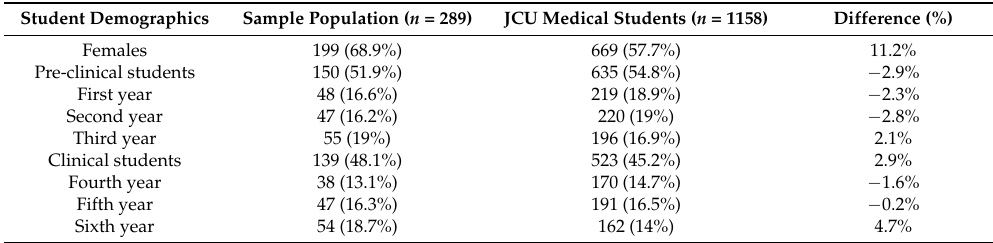
Table 1. Demographic profile of the sample population compared with the James Cook University (JCU) medical student population in 2014.